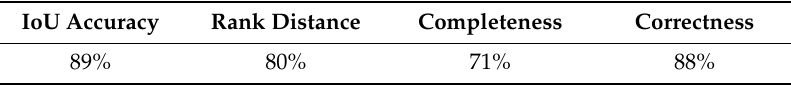
Table 5. Accuracy indices calculated for the North Sinai